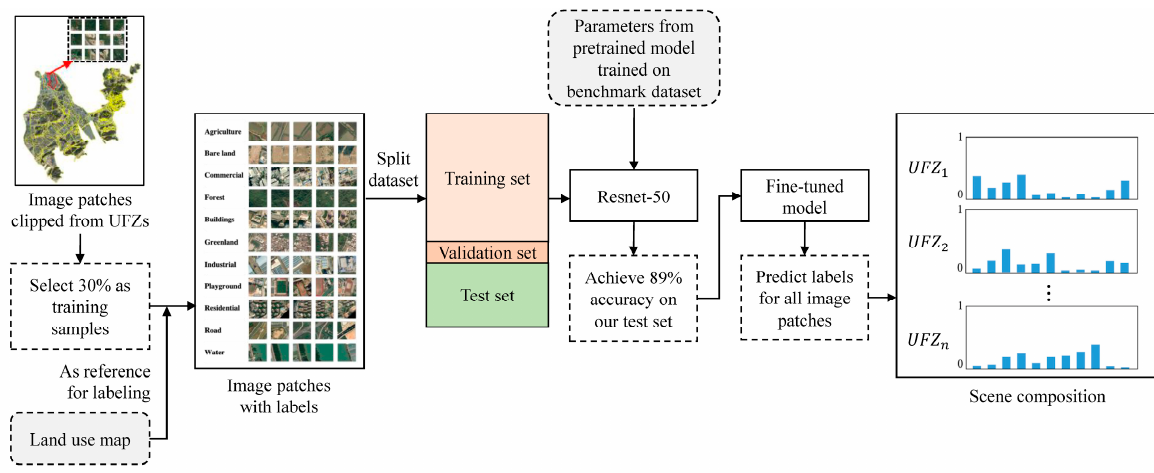
Figure 5. Procedures for extracting image scene compositions for